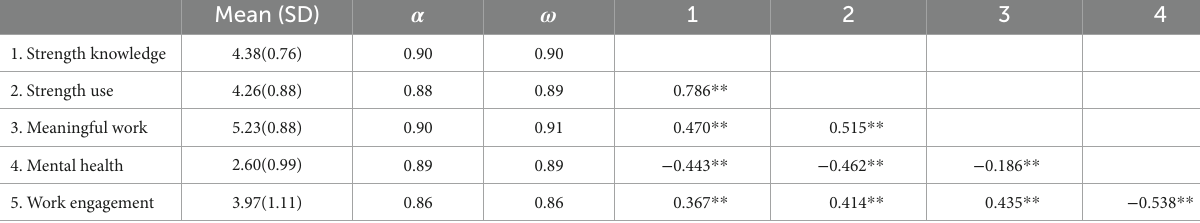
TABLE 7 Descriptive statistics, reliability coefficients, and Pearson’s correlations for all study 3 variables. Mean